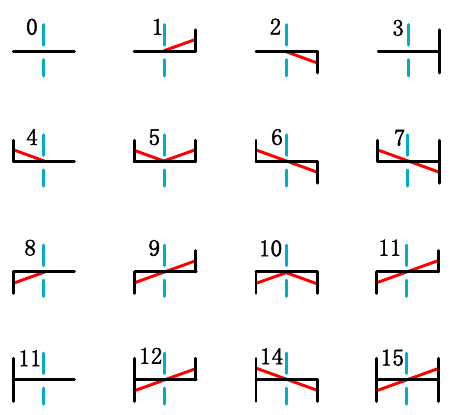
Figure 6. Horizontal aliasing patterns.